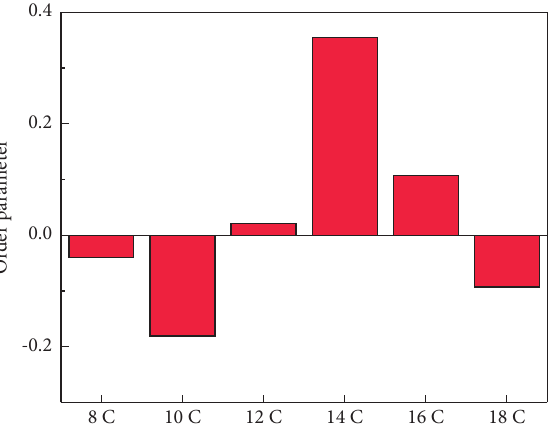
Figure 13: Order parameters of hydrophobic tails in different systems.